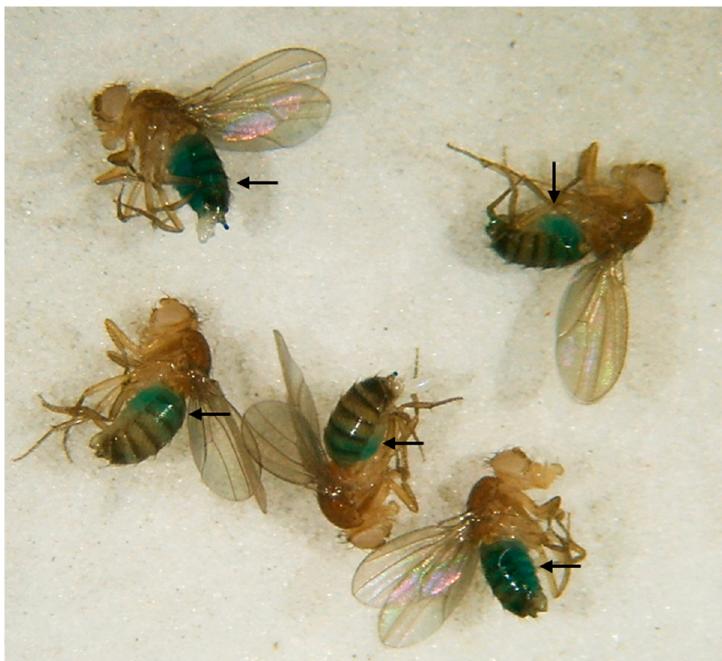
Figure 4. Determination of food intake with dyed medium. Flies are fed on medium supplemented with the nonabsorbable dye, Brilliant Blue FCF. After a defined period of time, the animals are removed, and dye accumulation within the digestive tract is indicated via assessment of the blue- colored abdomen (black arrows). The amount of ingested dye can be determined in the fly lysate by a spectrophotometer. The background absorption of fly lysates must be considered (modified from [10]).